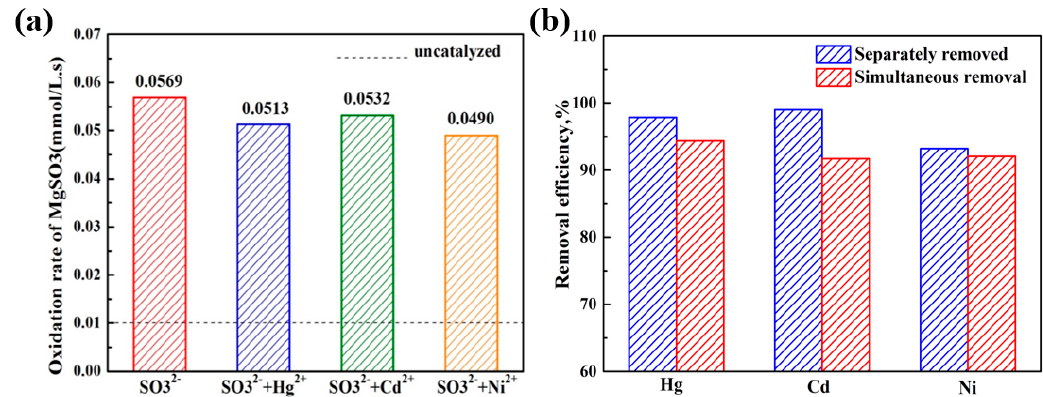
Figure 5. Simultaneous removal of Hg 2+ , Cd 2+ , Ni 2+ , and SO 32 − (Co wt % = 40%). ( a ) Effect of heavy metal ions on the oxidation rate of MgSO 3 . ( b ) Effect of SO 32 − on the removal efficiency of heavy metal ions.